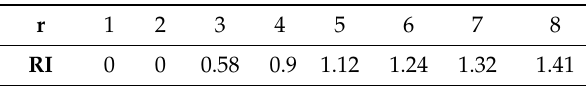
Table 3. Reference criterion (RI)